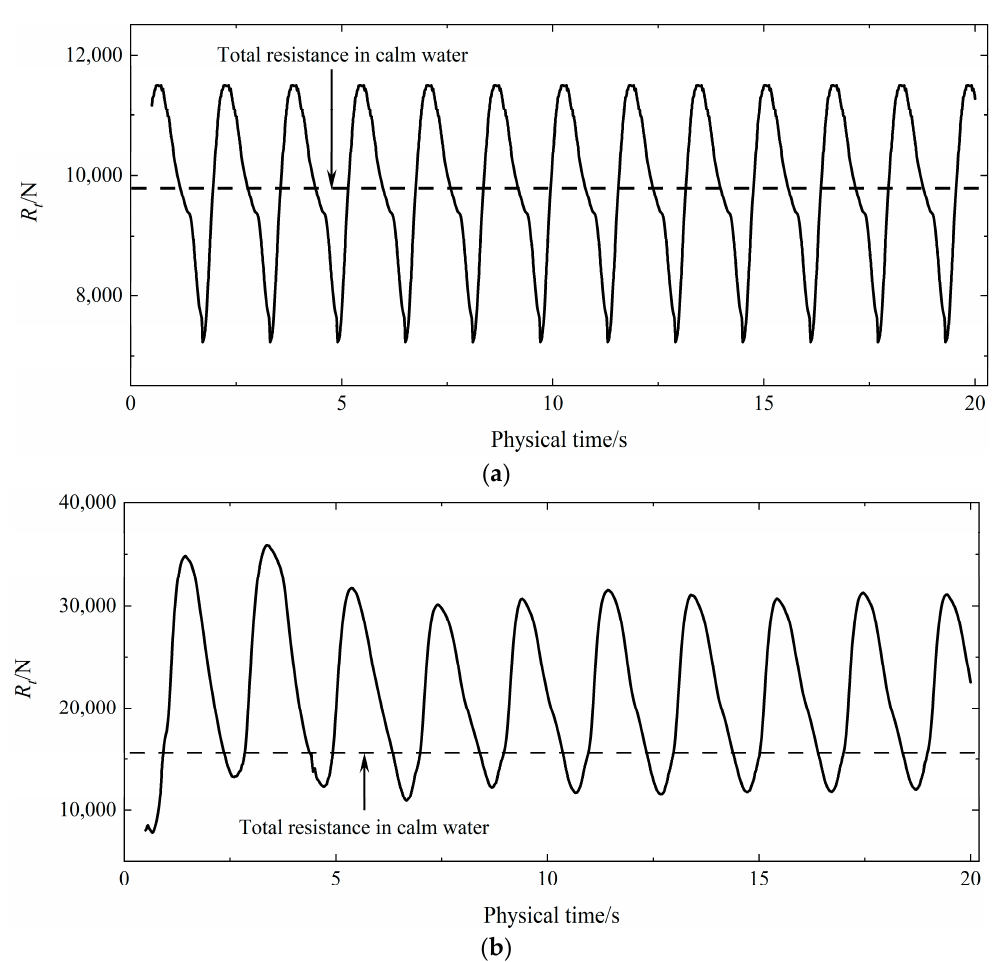
Figure 20. The time history curve of total resistance under case 6: ( a ) monohull; ( b ) pentamaran.